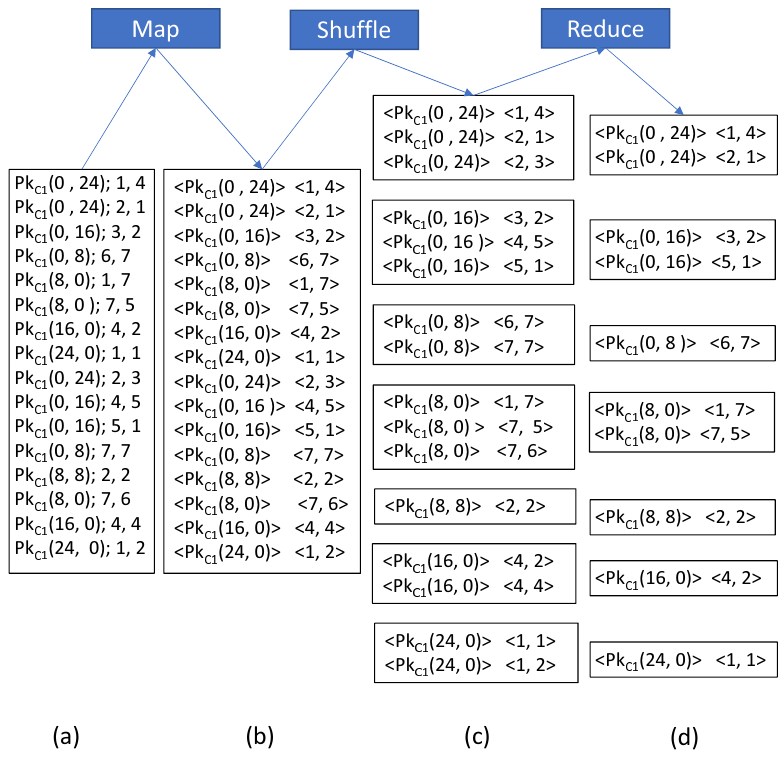
Figure 5. MapReduce-based cell-wise skyline computation. Here, Pk C 1 ( x , y ) means ( x , y ) is encrypted by Coordinator 1’s public key.